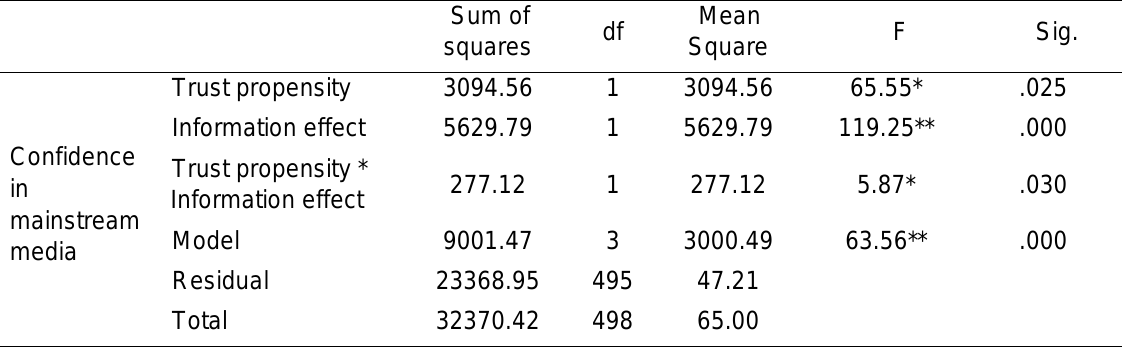
Table 3: Confidence in social media by trust propensity and information effect